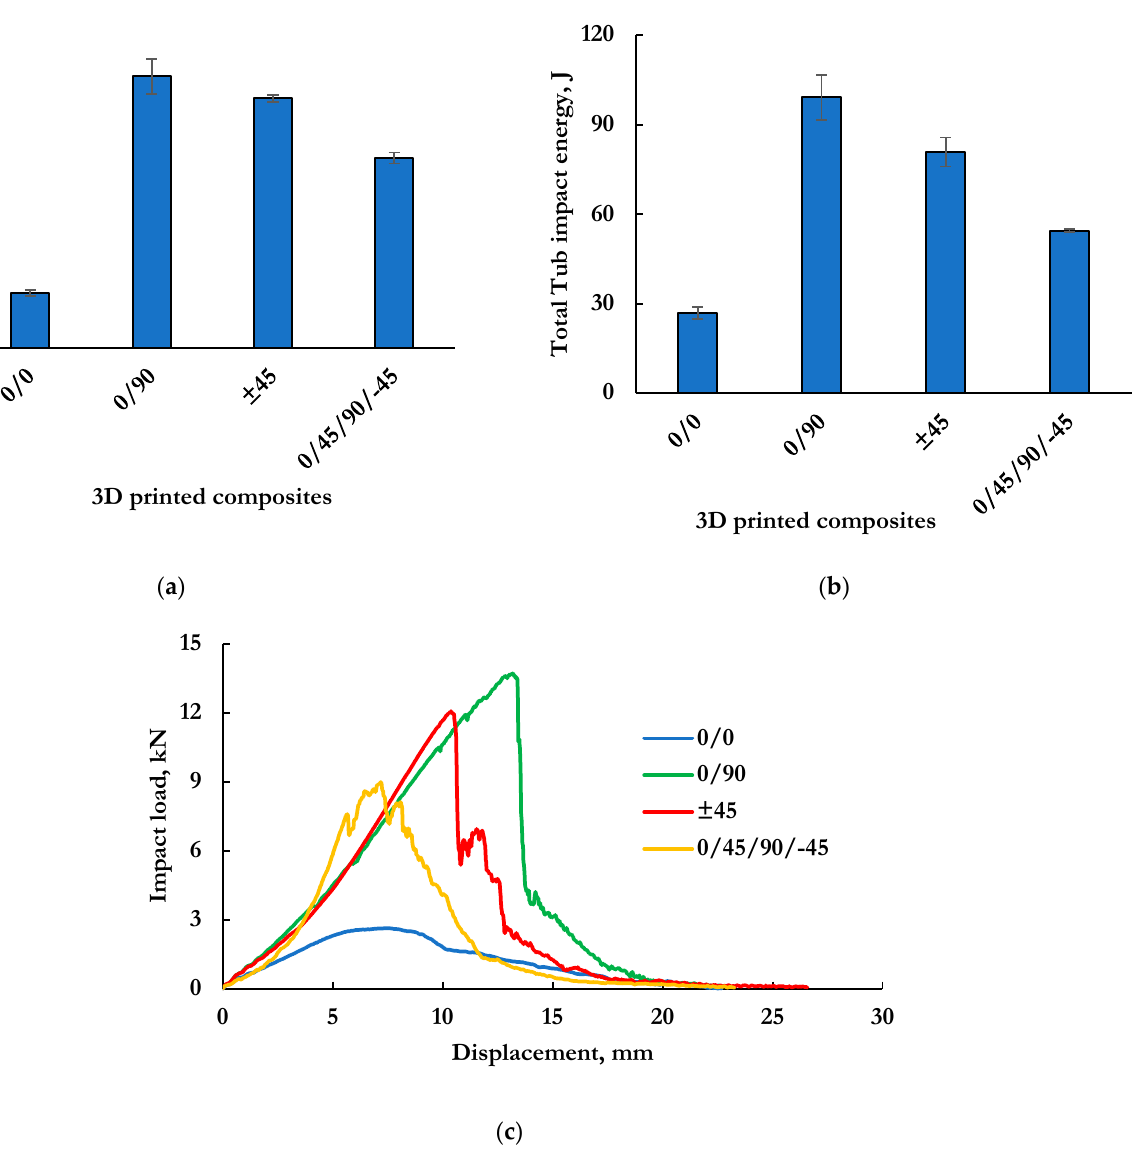
Figure 5. Drop-weight impact properties of the printed composites; ( a ) Tub impact peak force, ( b ) total Tub impact energy, and ( c ) impact load–displacement curves.